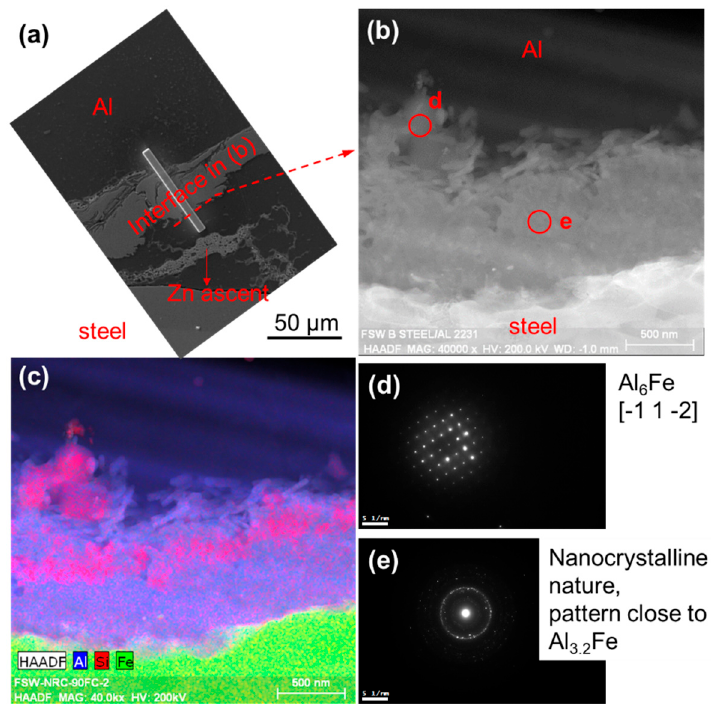
Figure 14. TEM micrographs of the interfacial microstructure at the hook zone of sample A: ( a ) focused ion beam (FIB) sampling position, ( b ) HAADF image, ( c ) EDS combination elemental map and SAD patterns of ( d ) Al6Fe and ( e ) nanocrystalline close to Al 3.2 Fe.